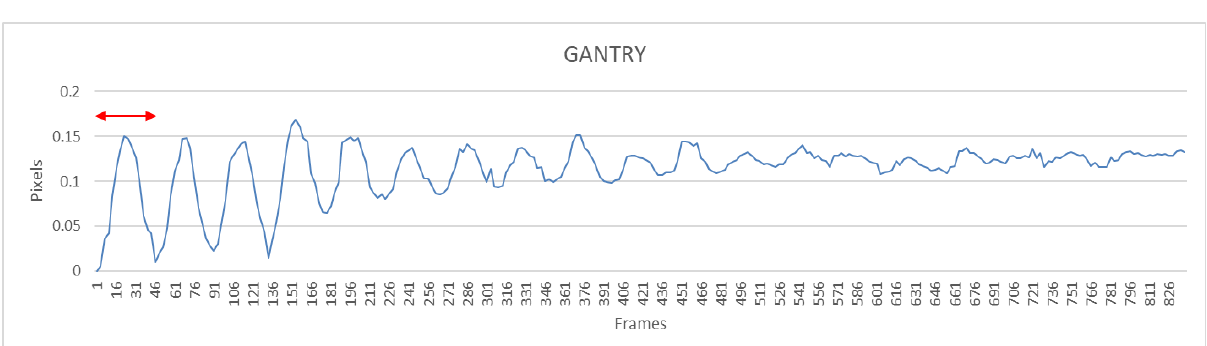
Figure 10 – DIC analysis’s results on the David’s Head (Chick).